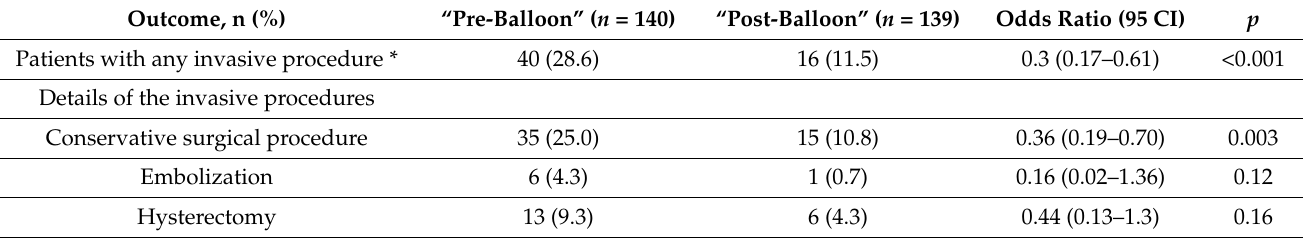
Table 2. Rates of the various invasive procedures implemented. Related odds ratios are expressed with their 95% confidence